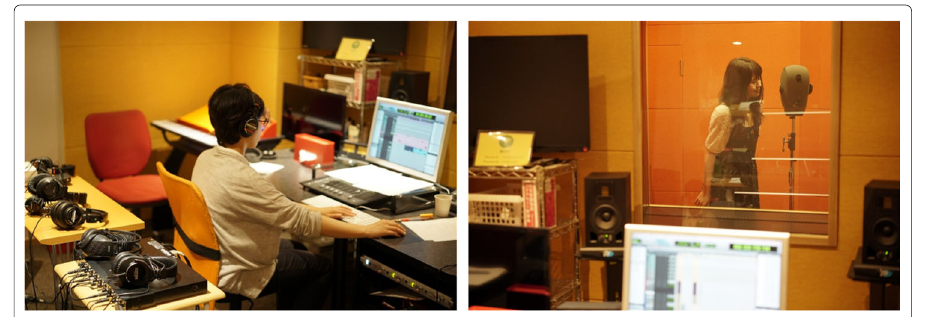
Fig. 2 Appearance of the recording